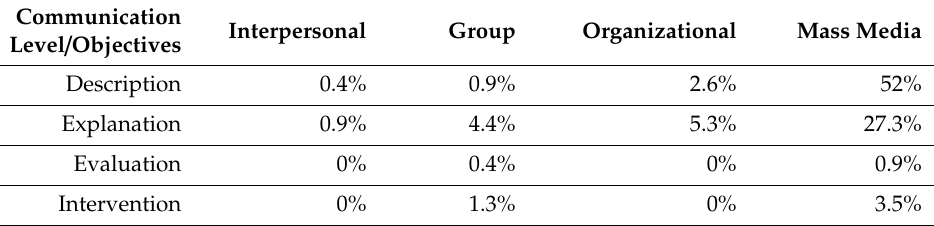
Table 1. Communicative level vs. research objectives.